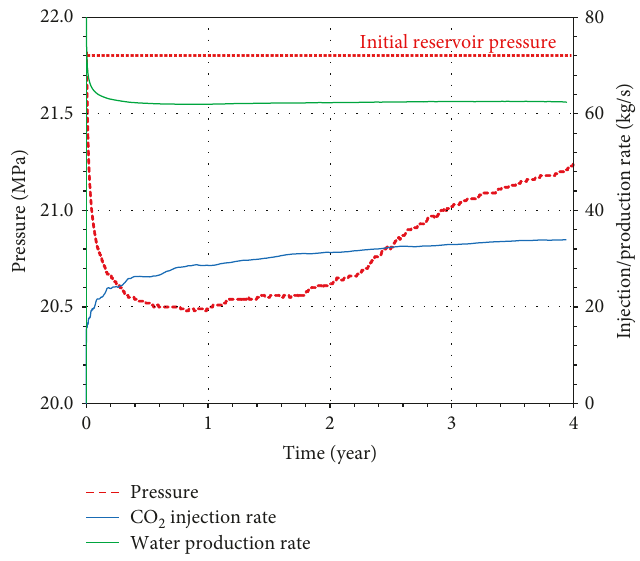
Figure 17: Temporal variation of the monitoring pressure and the injection and production